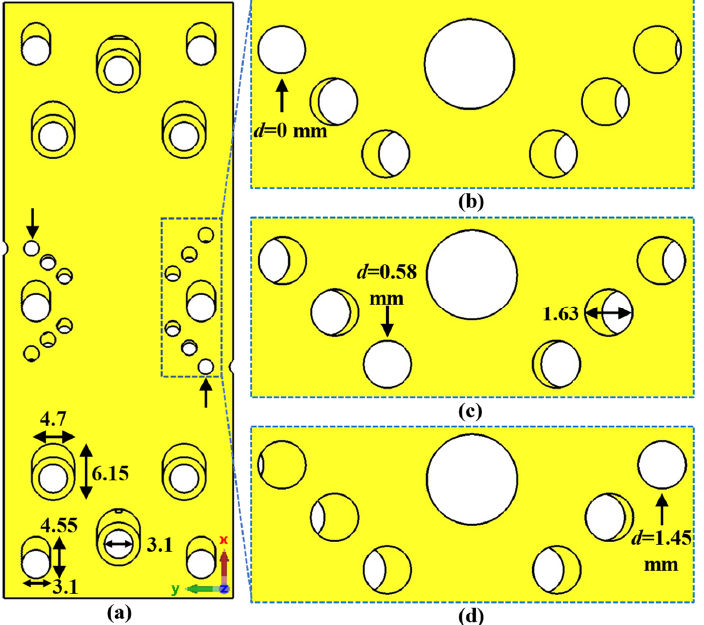
Figure 30. Detailed view of the holes for screws and for the alignment between both pieces that form the filter. ( a ) Top view and ( b – d ) detailed view of the alignment holes for different relative positions between pieces.